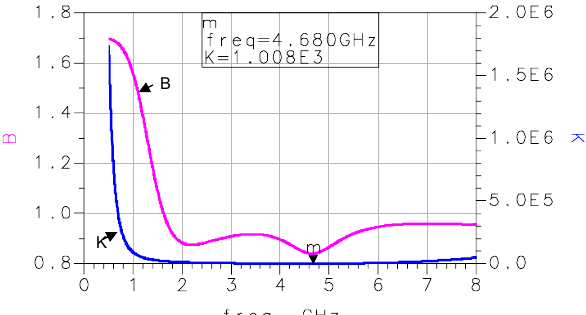
Figure 10. Stability coefficients K and B.